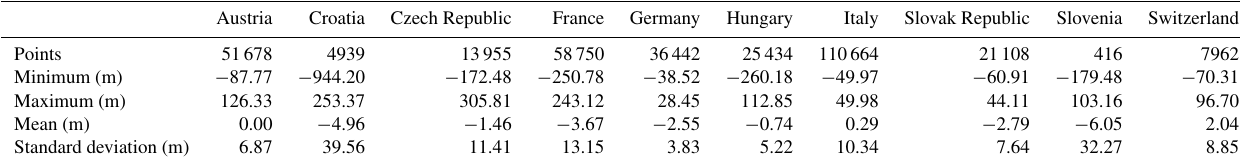
Table C5. Statistical results of test calculations of consistency of station heights and the MERIT DEM